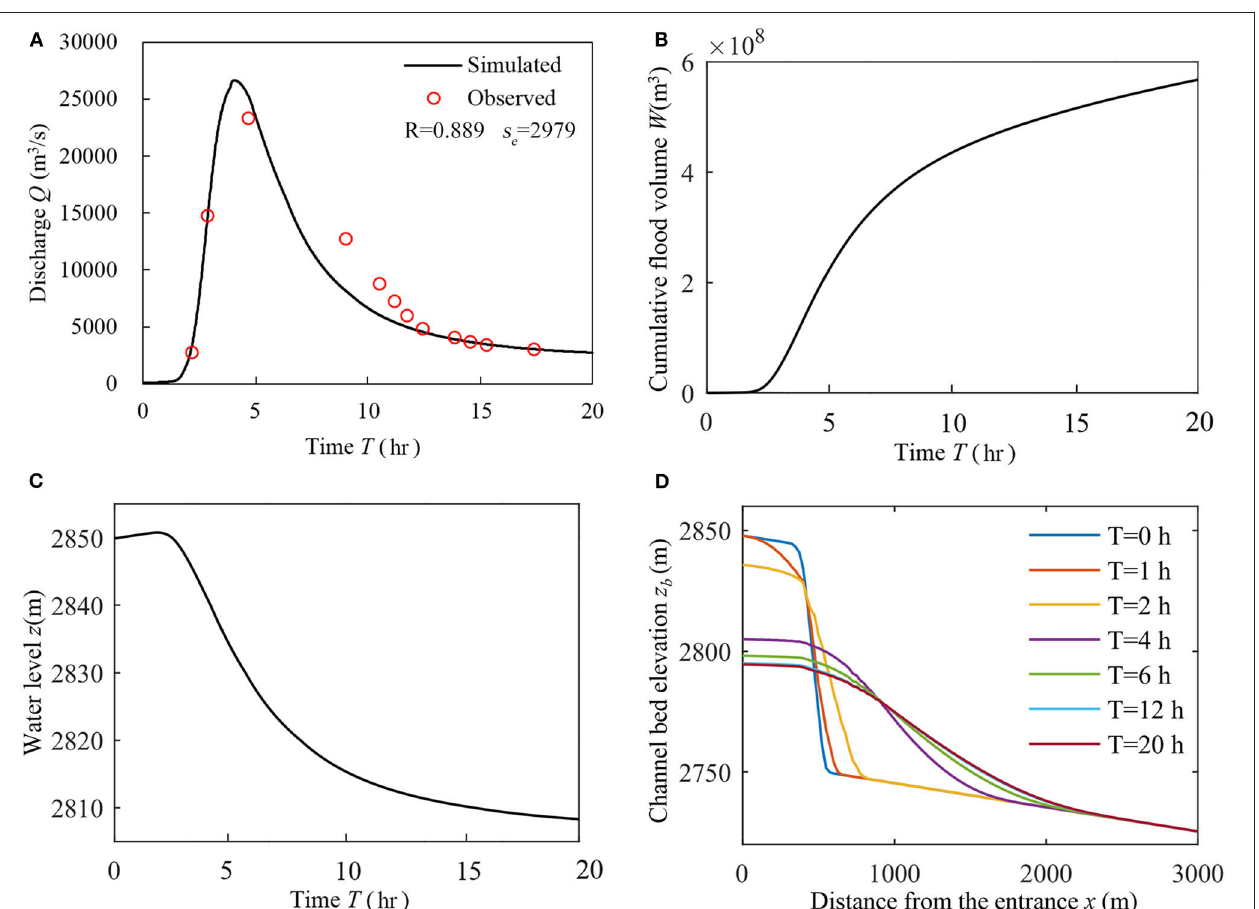
Frontiers in Water |